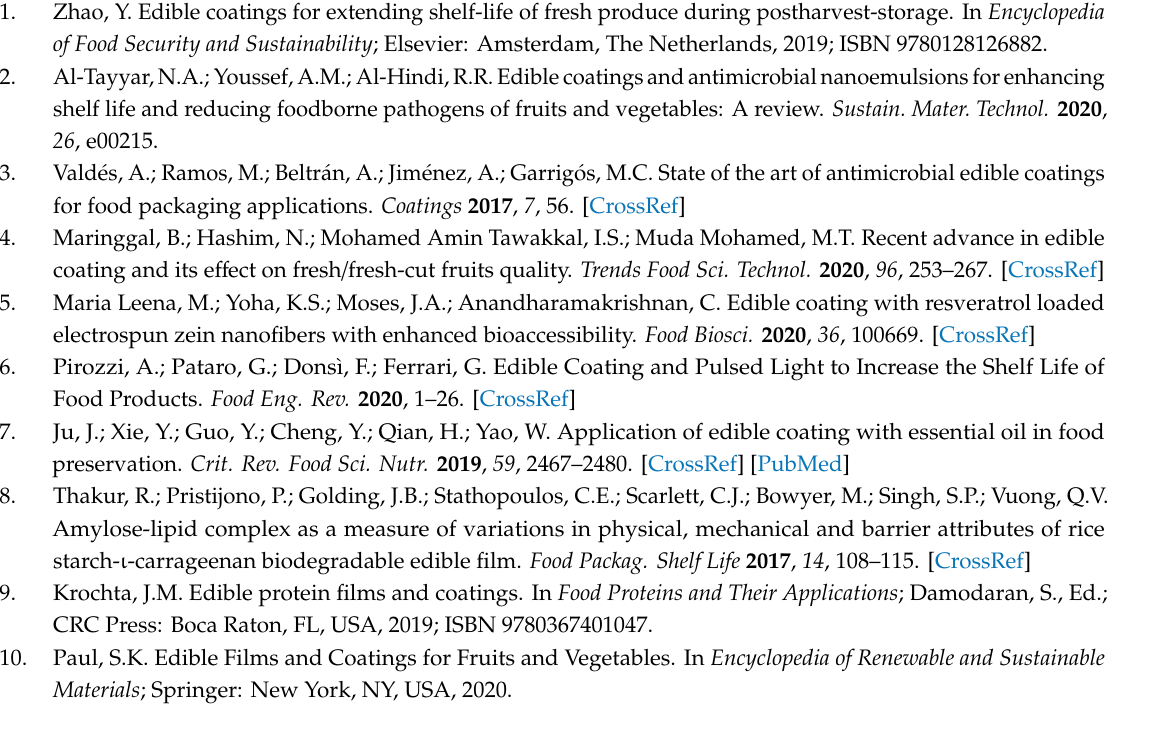
Figure S1: Calibration curve for UV–vis absorbance of OEO. Figure S2. Picture of coated tomatoes at di ff erent concentrations of the coating and cross-linking solutions. Figure S3: Contact angle over time of solutions on tomato skins (solution formulation given in the legend). Table S1: The central composite design used, with the indication of the actual value and the coded level (in parenthesis) of the three variables and the response variable. Table S2. Regression coe ffi cients, R2, F-test values (Freg), and probability p -values for thickness response. Table S3. Changes in the color parameters of tomato coated with calcium chloride cross-linked sodium alginate (with or without essential oils) during